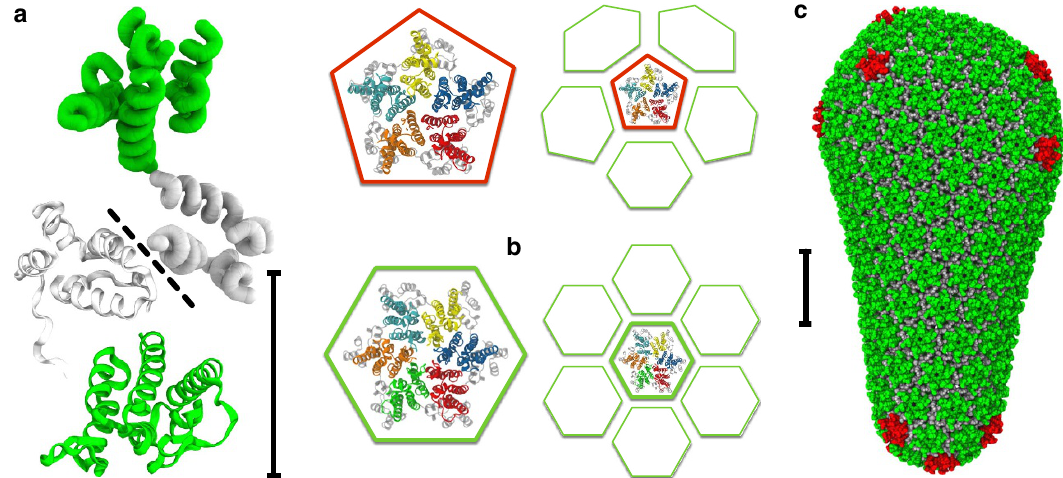
Figure 1 | The fullerene cone model of the HIV-1 capsid is assembled from ‘mature-style’ capsid lattice with hexameric (green) and pentameric (red) building blocks. ( a ) CA dimer structure with both CG (tube) and all-atom (ribbon) monomer representations (NTDs green and CTDs grey). CTD dimer interface marked by dashed line; scale bar, 5nm. ( b ) Quasi-equivalent pentamer and hexamer capsid inclusions (NTDs distinguished by colour, all CTDs grey), with schematic of adjacent packing in capsid lattice. ( c ) Mature capsid structure after Pornillos et al. 21 . NTDs of hexamer-associated CA shown in green, with NTDs of pentamer-associated CA shown in red (all CTDs grey); scale bar,